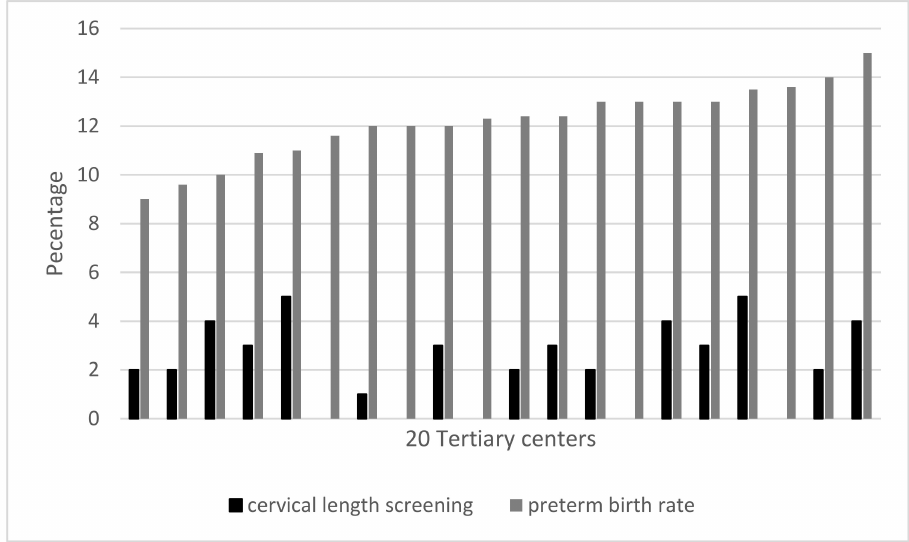
Figure 1. Proportions of women undergoing cervical length screening and preterm birth rates at 20 tertiary centers revealed via the Phase I in-depth